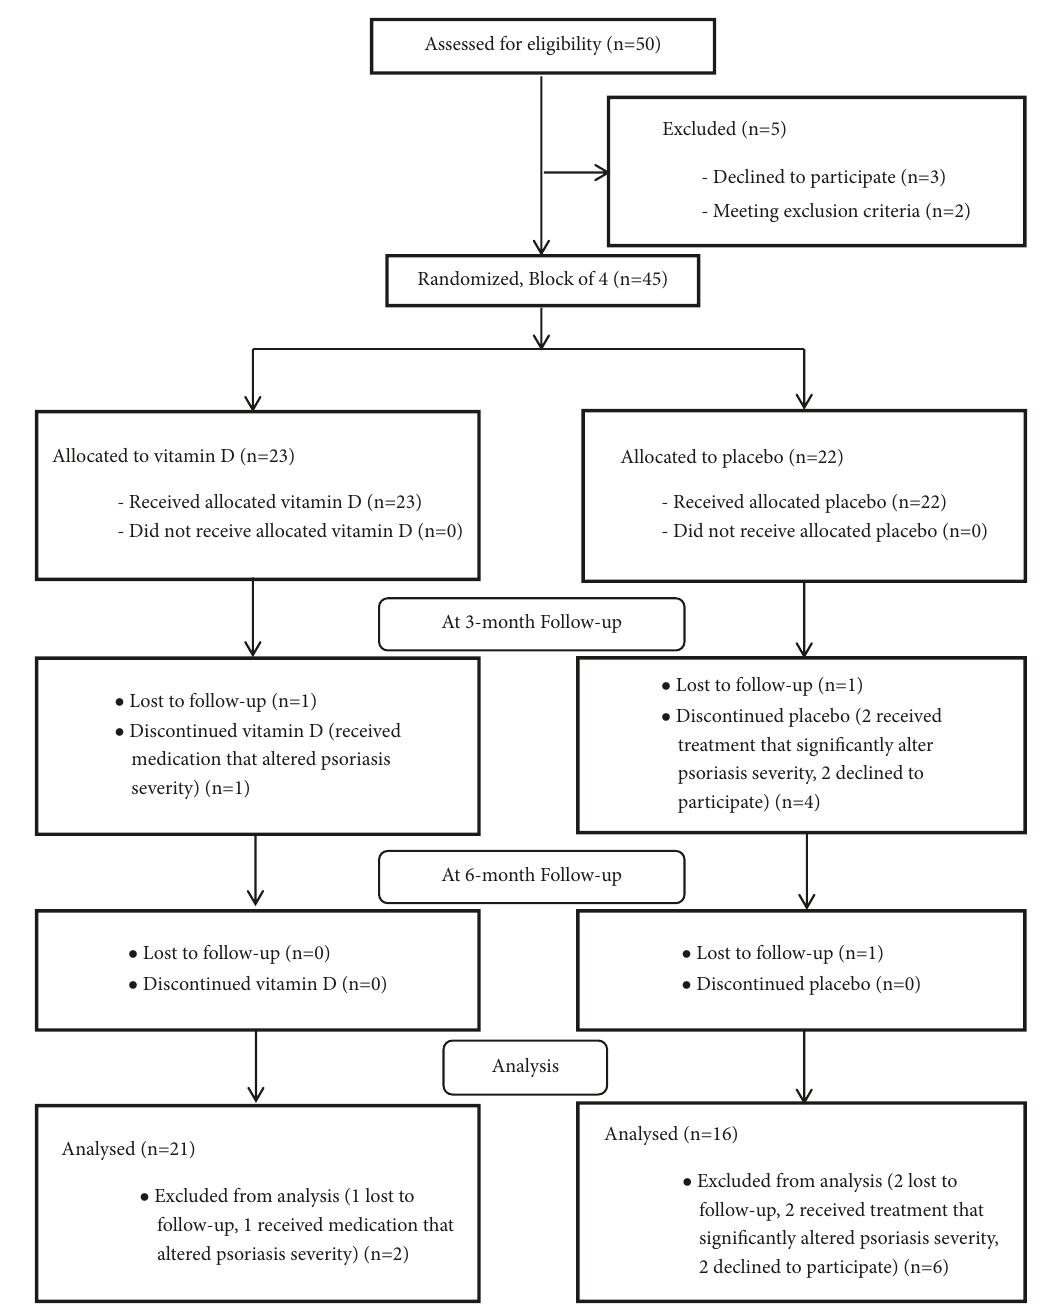
Figure 1: Diagram of patient